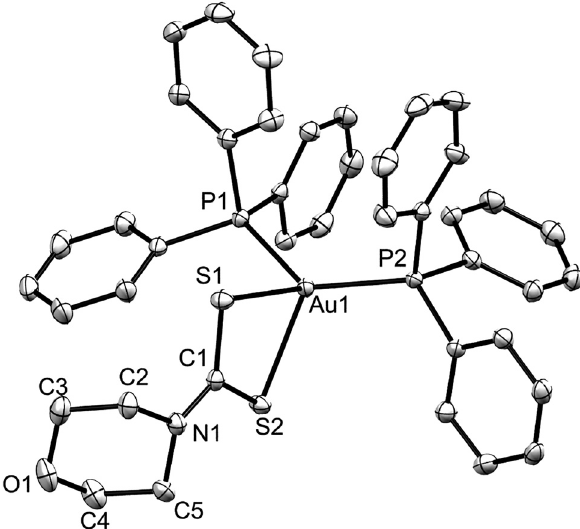
Table  : Data collection and